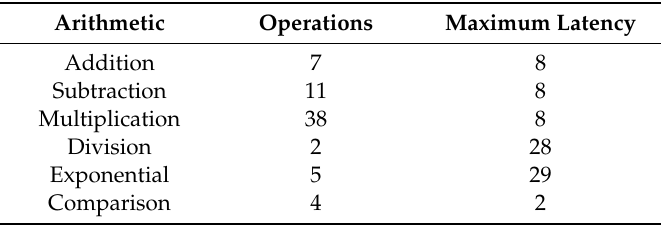
Figure 2. Direct hardware mapping block diagram. Table 1. Direct hardware mapping operation statistics.